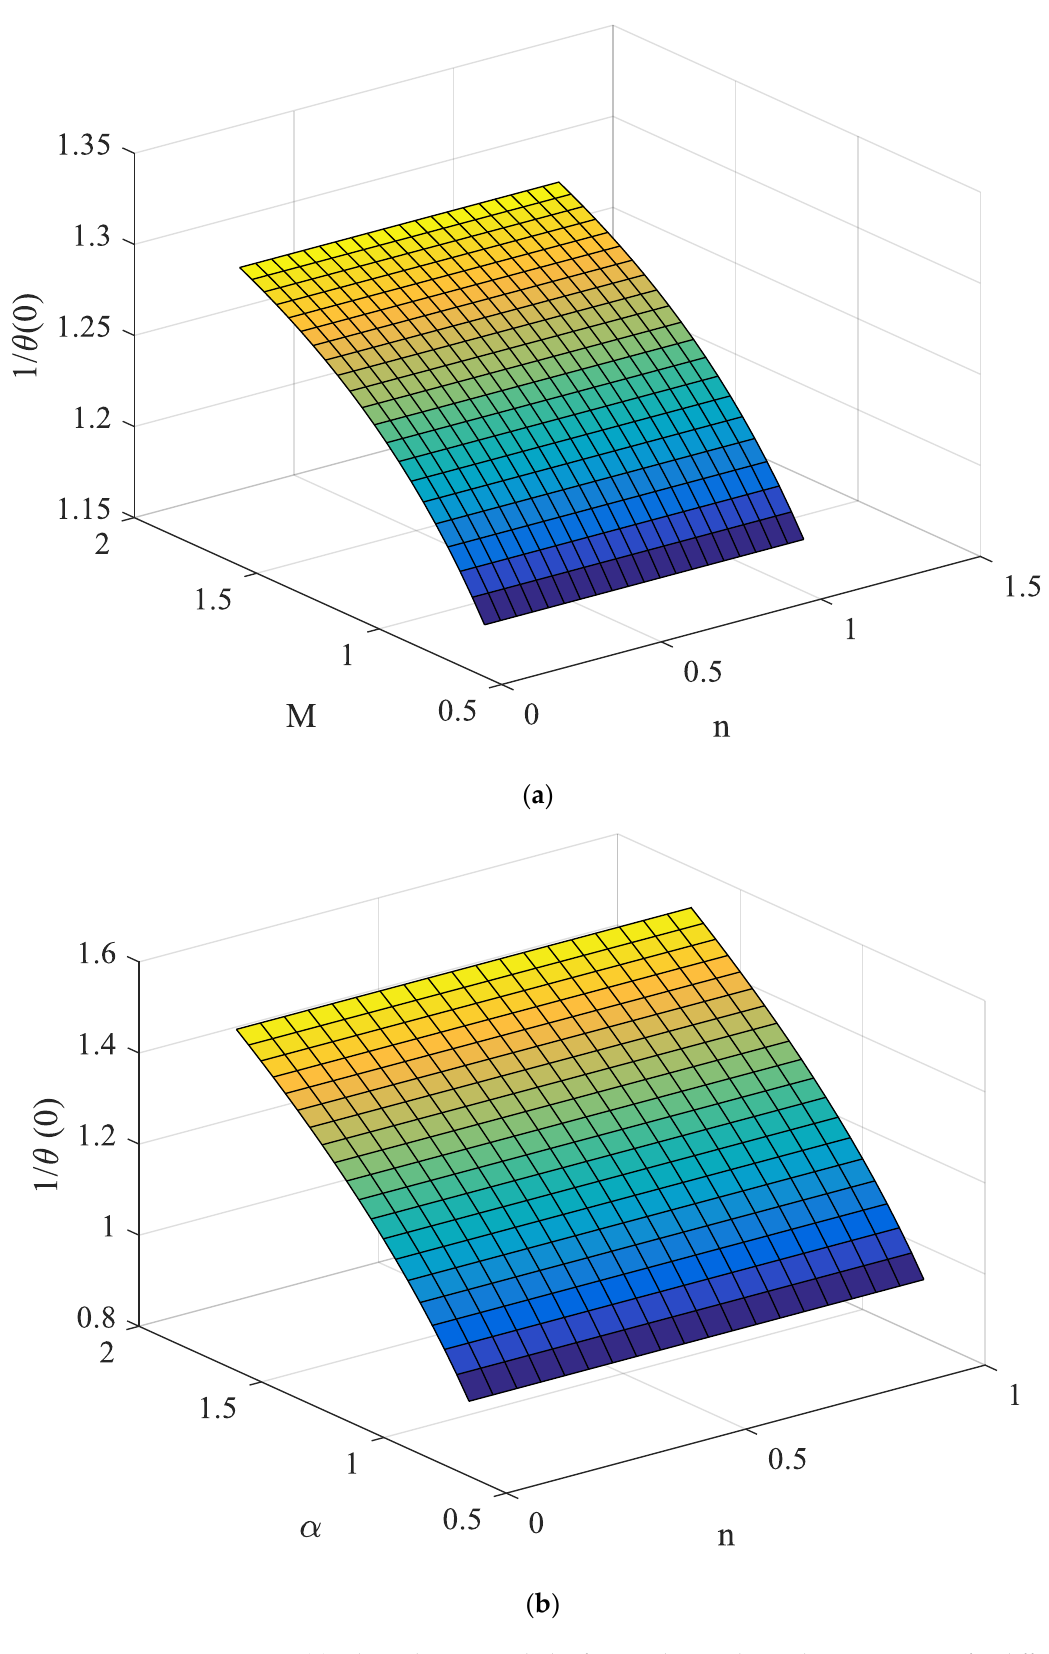
Figure 12. ( a ): Three-dimensional plot for Local Nusselt number in CHF case for different values of M & n . ( b ): Three-dimensional plot for Nusselt number in CHF case for different values of α & n .